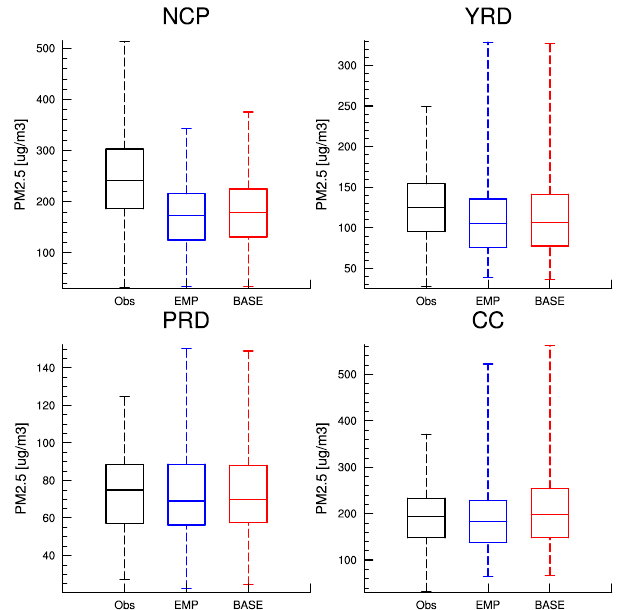
Figure 12. Time series of observed (black) and simulated (red for the BASE scenario, purple for the RAD scenario, and blue for the EMP scenario) daily total radiation and 2m temperature averaged over northern and central China in January 2013.